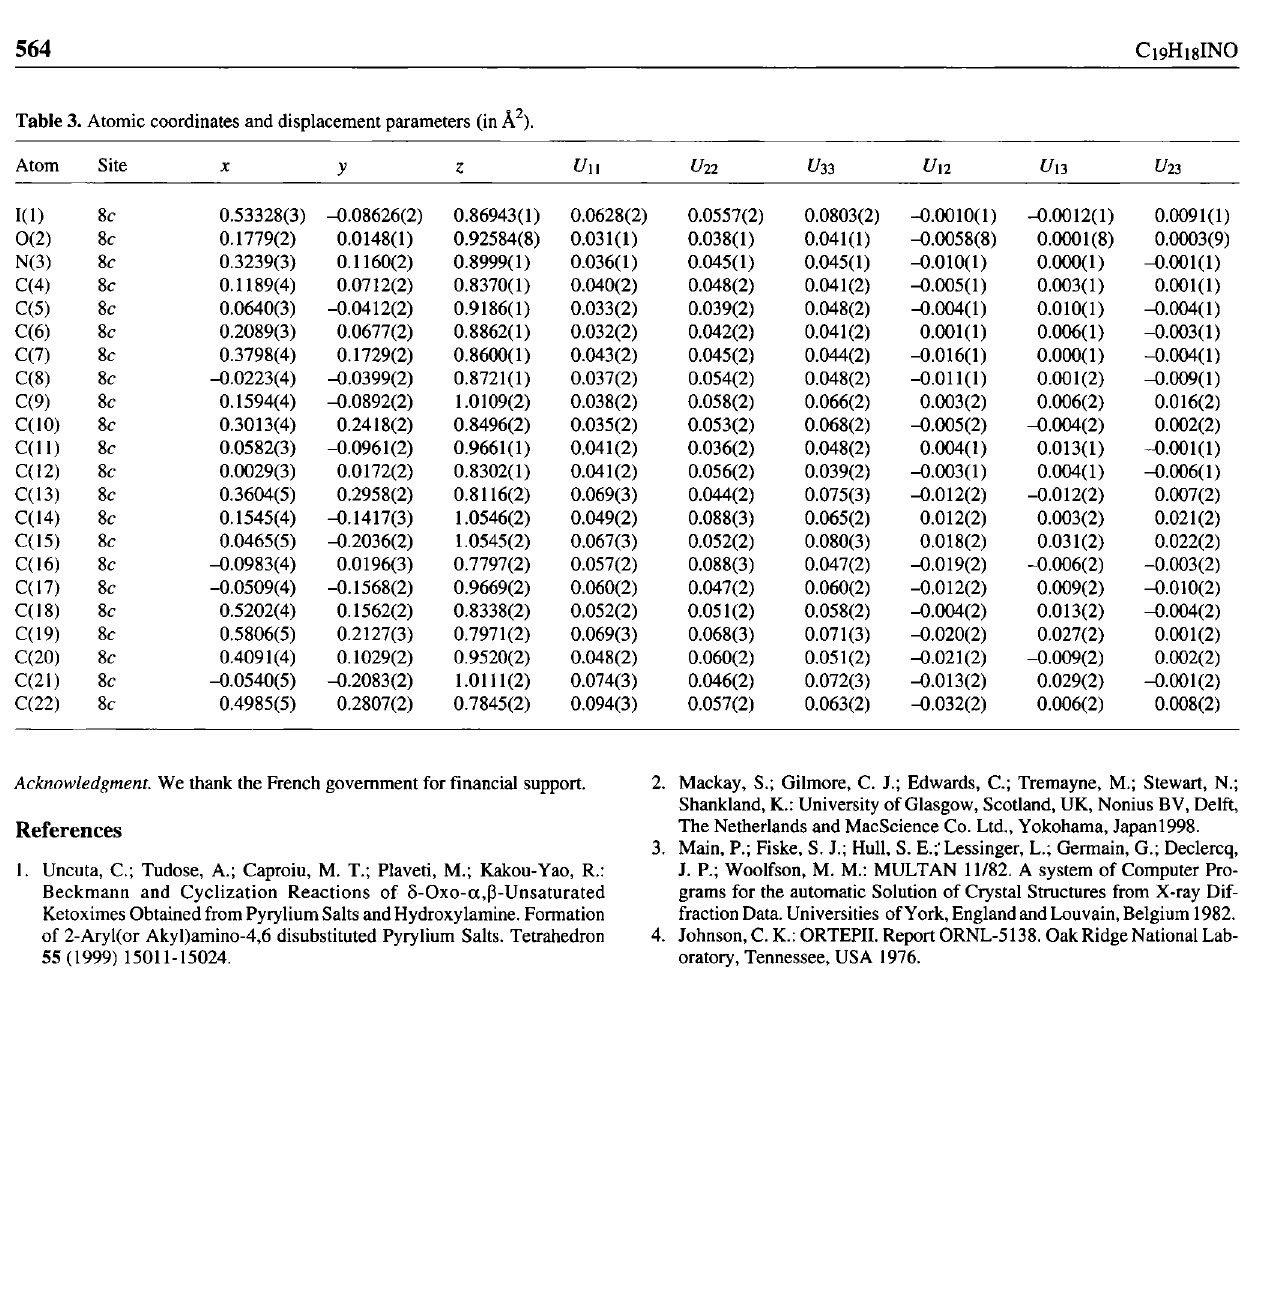
Table 3. Atomic coordinates and displacement parameters (in Â 2